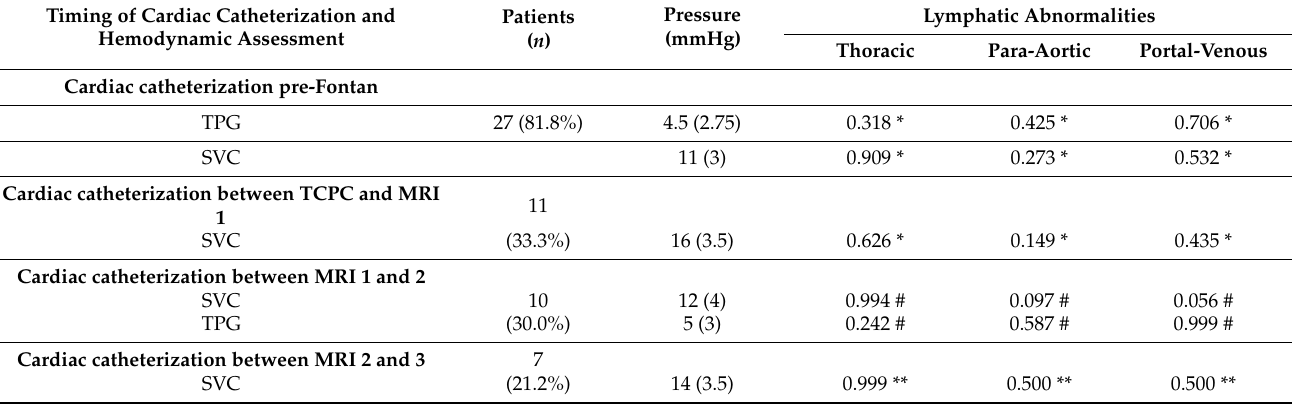
Table illustrating pressure values at cardiac catheter studies. The pressure values have been correlated with the lymphatic classification of the following MRI: * with results from 1st MRI. # with results from 2nd MRI. ** with results from 3rd MRI. Data are given as number (percentage) or median and interquartile range (IQR). Abbreviations: transpulmonary gradient (TPG), superior vena cava (SVC), magnetic resonance imaging (MRI), total cavopulmonary connection Figure 4. Example of lymphatic abnormalities after cardiac catheter intervention. ( A ) Patient who underwent first cardiac MRI at 13 years of age showing moderate left pulmonary artery (LPA) ste- nosis. The T2-weighted imaging showed significant thoracic lymphatic abnormalities (type 4) and para-aortic and portal-venous abnormalities type 3. The 2nd MRI was performed after cardiac cath- eterization and LPA stent implantation showing mildly improved thoracic lymphatic abnormalities. ( B ) 25-year-old Fontan patient in good clinical condition presented with significant stenosis of the right pulmonary artery (RPA) on 1st MRI. Cardiac catheter intervention with balloon dilatation of the RPA and closure of a major aortopulmonary collateral (MAPCA) from the descending aorta was performed. Repeat MRI at the age of 30 years showed improvement in lymphatic abnormalities in all three compartments. Lymphatic abnormalities are highlighted in green.